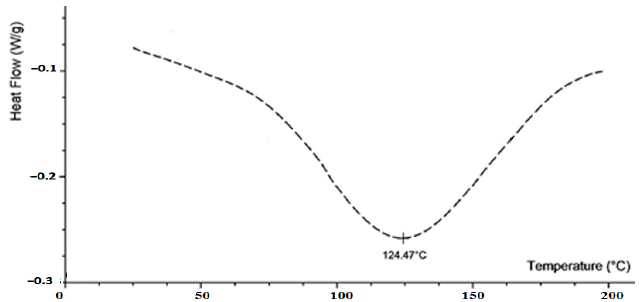
Figure 5. Phase transitions for the dry stationary phase checked by DSC (differential scanning calorimetry).